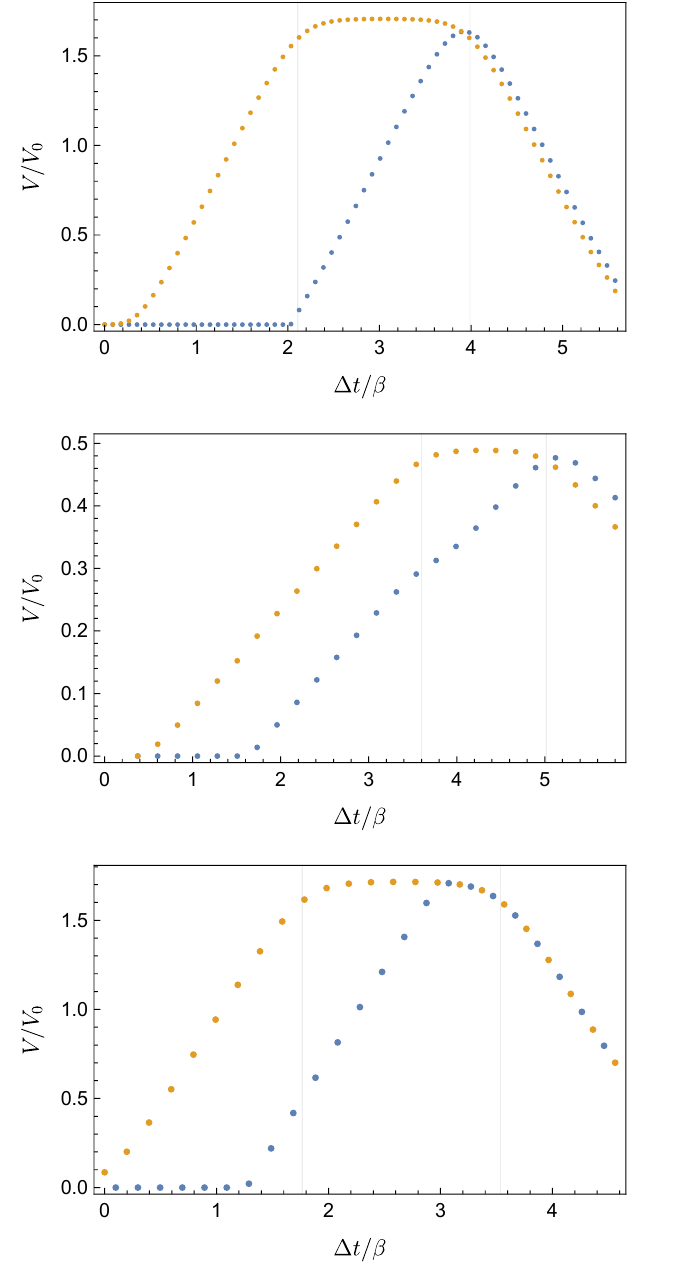
Figure 9 . Spacetime volumes of post-collision regions as a function of ∆ t in various examples. The spacetime volumes are given in units of V 0 = 4 π ( r 3 − r 3 ) β/ 3 and ∆ t is given in units of + − β . The scrambling times of the two neutral shells are marked as vertical grey lines. Top panel: a black hole with medium charge r − ∼ r + / 2 ( r + /l ’ 4 . 82 and r − /l ’ 2 . 12 ) with perturbations of size E/M = 5 × 10 − 6 and ( E − µq ) /M ’ 3 . 74 × 10 − 11 . Middle panel: a black hole far from extremality ( r + /l ’ 31 . 5 and r − /l ’ 1 . 27 × 10 − 4 ) with perturbations of size E/M ’ 1 . 91 × 10 − 9 and ( E − µq ) /M ’ 2 . 67 × 10 − 13 . Bottom panel: a black hole close to extremality ( r + /l ’ 31 . 6 and r − /l ’ 30 . 5 ) with perturbations of size E/M ’ 3 . 33 × 10 − 8 and ( E − µq ) /M ’ 4 . 89 × 10 − 13